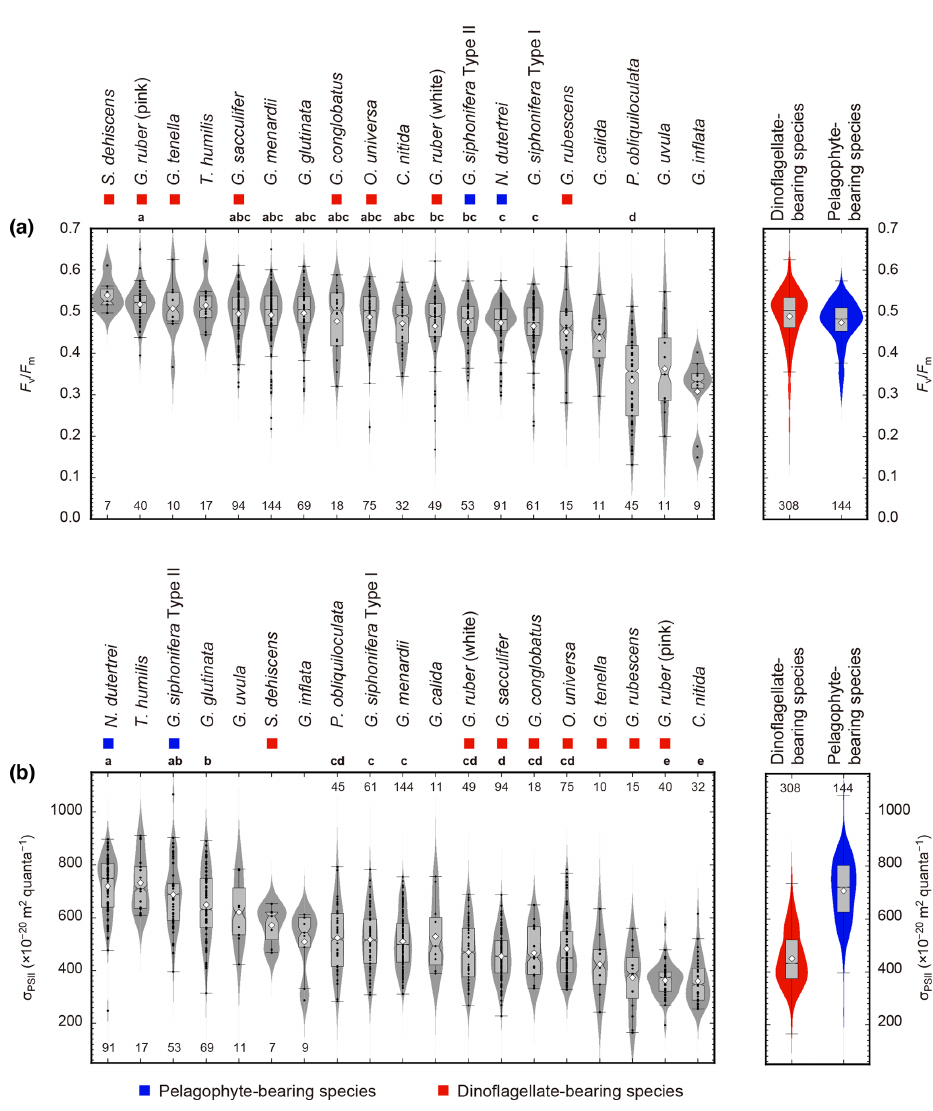
Figure 8. Photophysiological parameters of 19 symbiont-bearing species. (a) F v /F m and (b) σ PSII . Dots represent individual data sampled from the upper 100m water depth. Box plots represent first and third quartiles as hinges, and midlines represent medians with notches representing the 95% confidence intervals of the medians. Means are also represented with open diamonds. Values which lie more than 1.5 times the length of the box from either end of the box are considered as outliers. Violin plots show the distributions as kernel density estimation. Numbers at either end of the panels are the sample size for each species. Species with more than 20 specimens were used for statistical testing (Kruskal–Wallis test for comparison of differences in medians, and post hoc Steel–Dwass test for multiple comparison, p< 0 . 05). Species sharing the same letter were not significantly different. Color symbols represent the difference of symbiotic algae (see Table